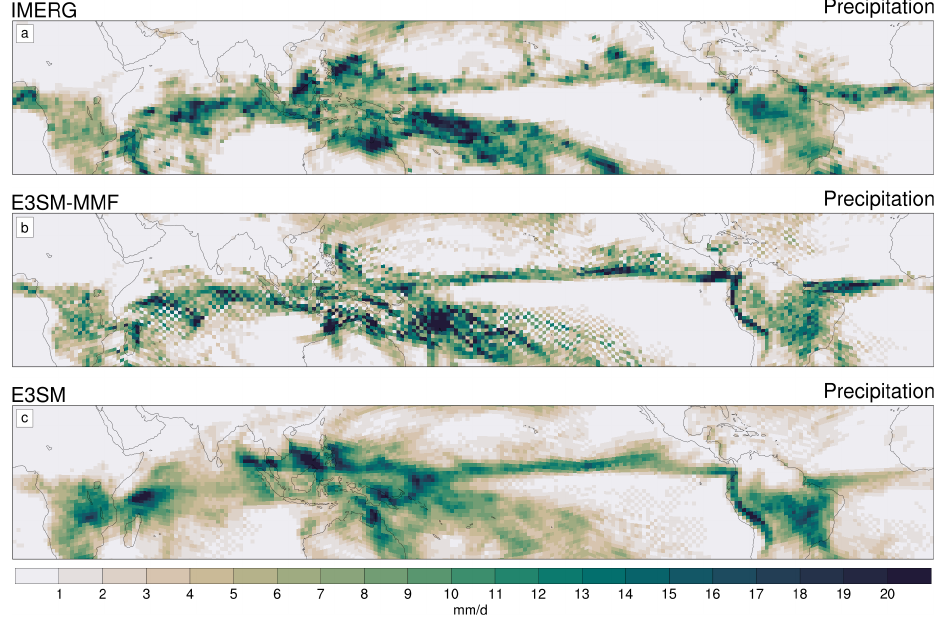
Figure 2. Single-month mean maps for an arbitrarily chosen January of precipitation data from IMERG, E3SM-MMF, and E3SMv2. Data are plotted on the native ne30pg2 physics grid using shaded polygons in order to see signals at the grid